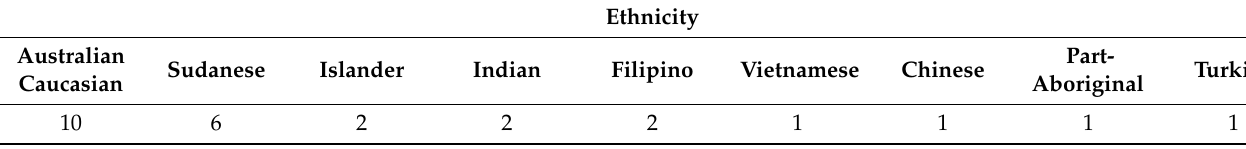
Table 1. Summary profile of student ethnic backgrounds. Male: 13, female: 13, total 26.